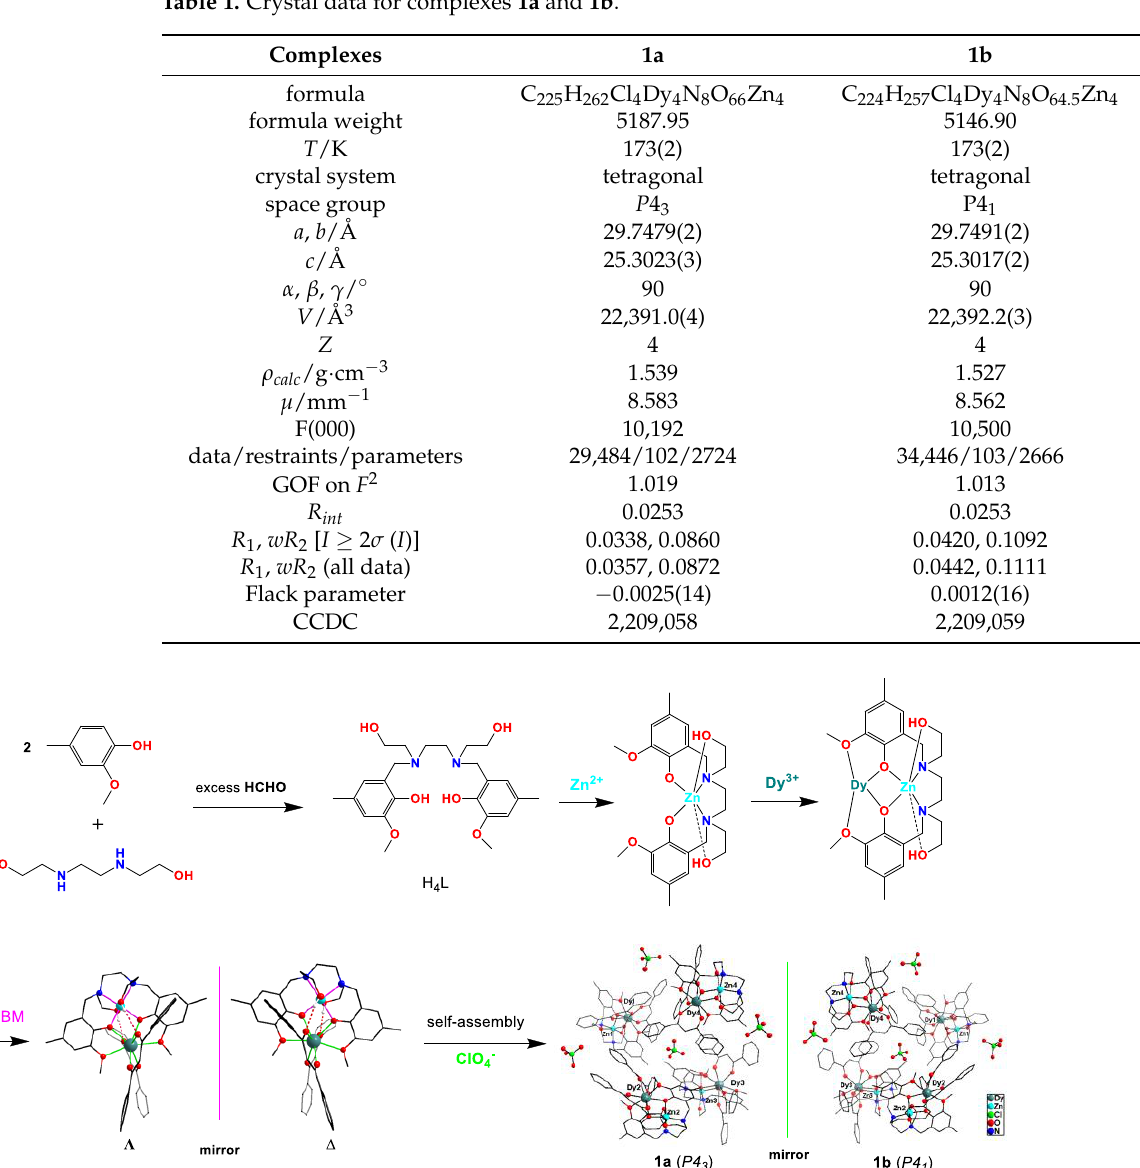
Figure 1. The formation process of complexes 1a ( P 4 3 ) and 1b ( P 4 1 ). Table 1. Crystal data for complexes 1a and 1b .